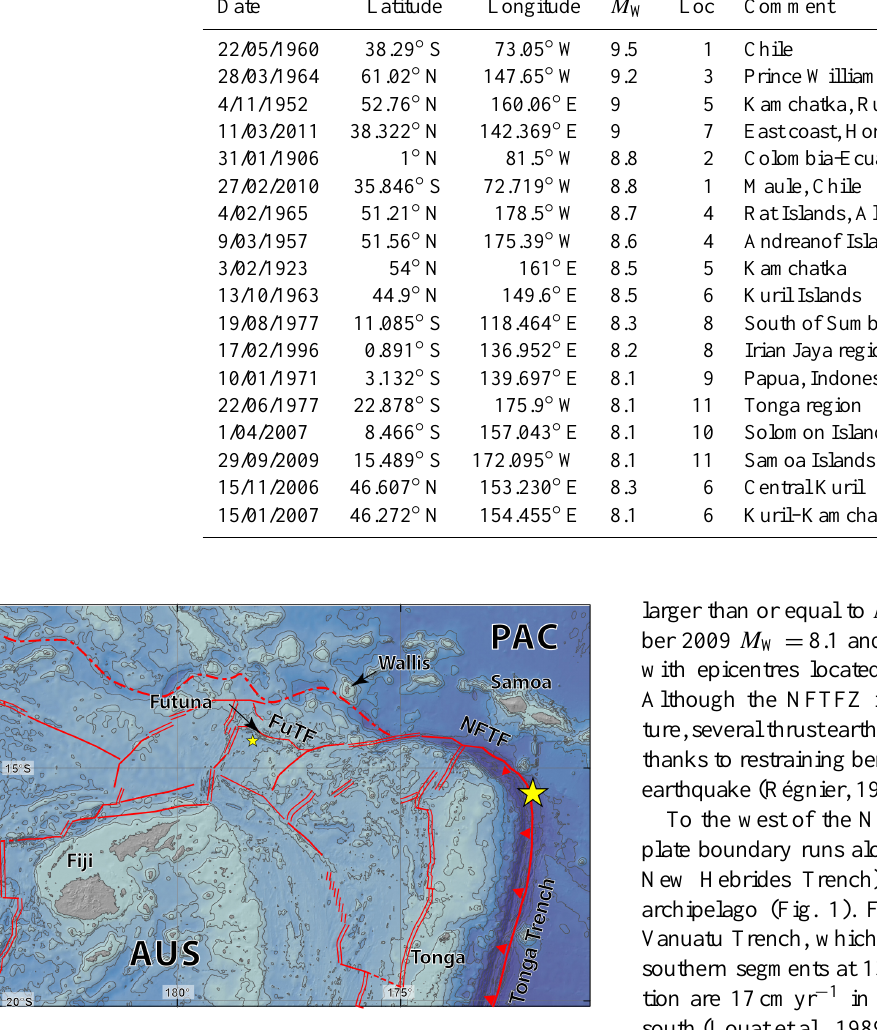
Figure 2. Seafloor morphology and main tectonics features of the northern Fiji Basin. Double red lines indicate active spreading cen- tres; plain lines are fracture zones; dash lines are inactive struc- tures, and teeth line indicates the subduction front of the Pacific- Australia (PAC-AUS) plate boundary. NFTF: North Fiji Transform Fault Zone; FuTF: Futuna Transform Fault. Large yellow star is epi- centre of the 29 September 2009 South Pacific Earthquake; small yellow star is epicentre of March 1993 Futuna Earthquake (Monzier et al., 1993; Régnier,